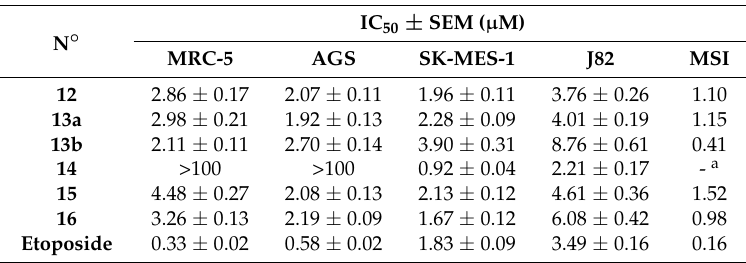
Table 4. In vitro cytotoxic effect of the bromine compounds 12 , 13a , 13b , 14 , 15 , and 16 on human-derived tumor cell lines: AGS (gastric), SK-MES-1 (lung), J82 (bladder), and the non-tumor fibroblasts (MRC-5).